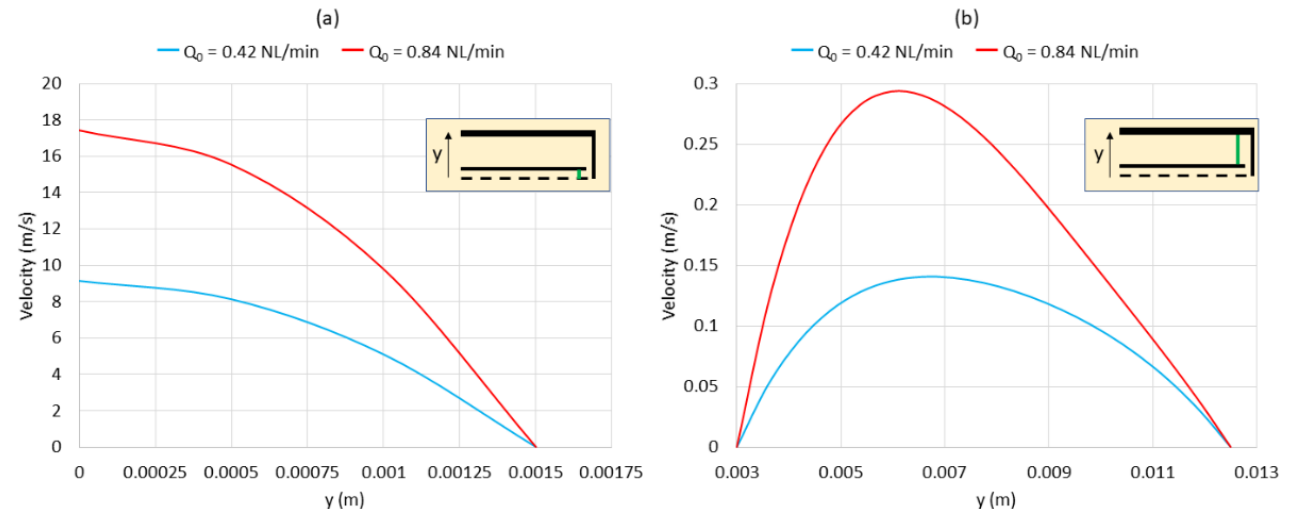
Figure 12. Velocity plots according to the direction of the y-axis 20 mm above the bottom (along the green line): ( a ) velocity in the inner tube and ( b ) velocity in the annular space. Blue curves: case 1; red curves: case 3.